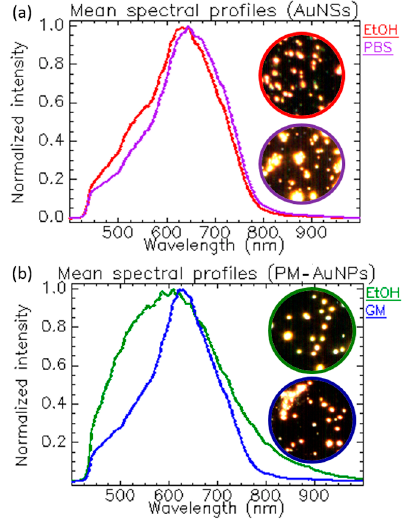
Figure 5. Influence of the solvents’ ionic strength and composition. ( a ) Spectral changes correlated with the agglomeration state of the AuNSs; ( b ) prominent spectral change in GM resulting from the formation of the so-called protein corona around the surface of the PM–AuNPs. AuNSs and PM–AuNPs were synthesized in our lab following synthesis methods published elsewhere [13,14]. CytoViva setup and ENVI 4.8 software were used for the hypercube acquisition and analysis.